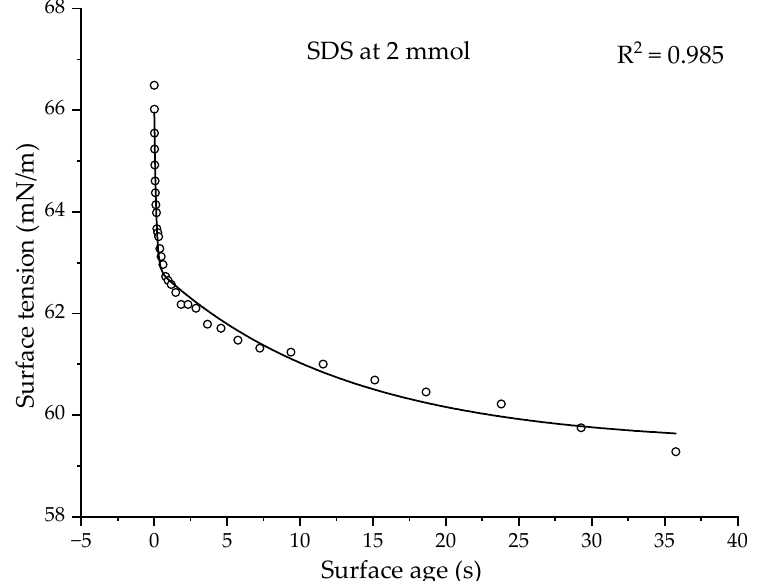
Figure 13. Dynamic curve of SDS at 2 mmol concentration. Reprinted (adapted) with permission from Christov, N. C., Danov, K. D., Kralchevsky, P. A., Ananthapadmanabhan, K. P., Lips, A. Maximum bubble pressure method: Universal surface age and transport mechanisms in surfactant solutions. Langmuir , 2006 , 22 , 7528-7542. Copyright 2019 American Chemical Society.